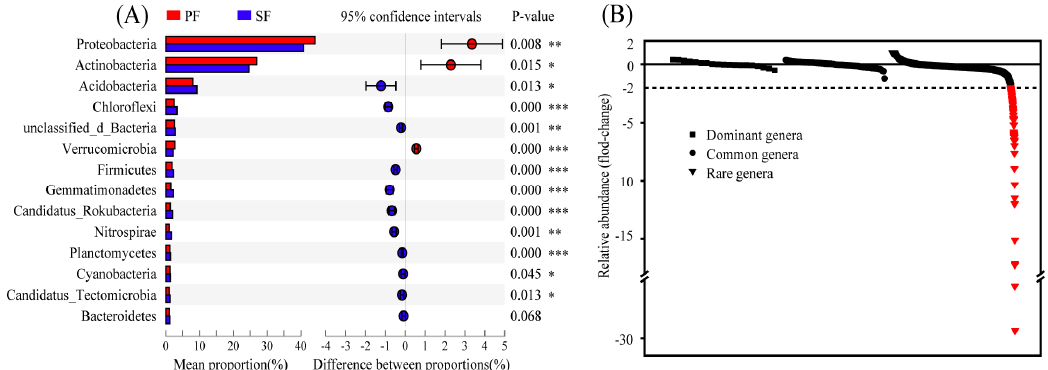
Figure 3. ( A ) The comparison of phyla with the relative abundance greater than 1% between primary Korean Pine forests (PF) and secondary broad ‐ leaved forests (SF). Different colours denote different forest types. ( B ) Fold ‐ changes in the relative abundance of genera. Fold ‐ change is defined as (PF ‐ SF)/PF, in which PF is the relative abundance of genera in the primary Korean Pine forests and SF is the relative abundance of genera in the secondary broad ‐ leaved forests. Red, fold ‐ changes > 2. Dominant genera: > 1%, Common genera: 0.1%–1%, Rare genera: < 0.1%. p < 0.05 indicates significant differences between the two different forest types. p < 0.05 *, p < 0.01 **, p < 0.001 ***.